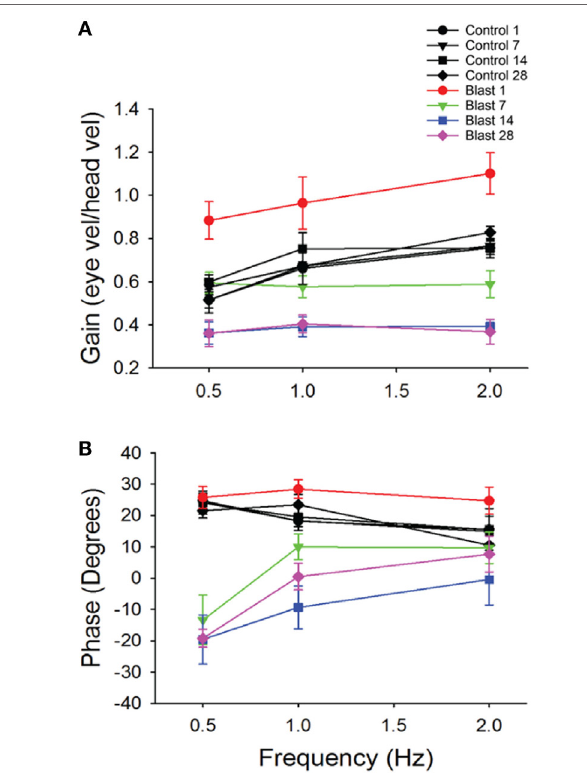
FigUre 3 | Vestibuloocular reflex (VOR) responses. Mean horizontal VOR responses for control (black, n = 10) and blast (colors, n = 10) animals on days 1, 7, 14, and 28 post-blast exposure as a function of rotation frequency. Mean horizontal vestibuloocular reflex gain (a) and phase (B) values for 0.5, 1.0, and 2.0 Hz (20°/s peak velocity). Error bars =